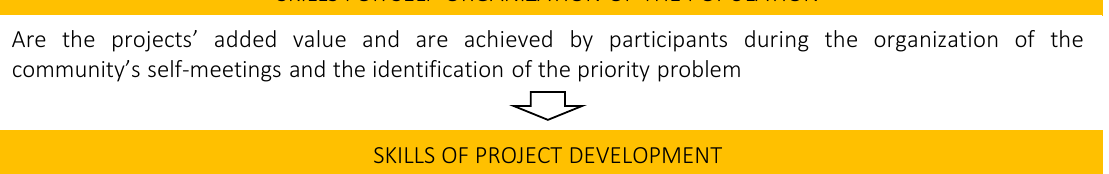
SKILLS FOR SELF-ORGANIZATION OF THE